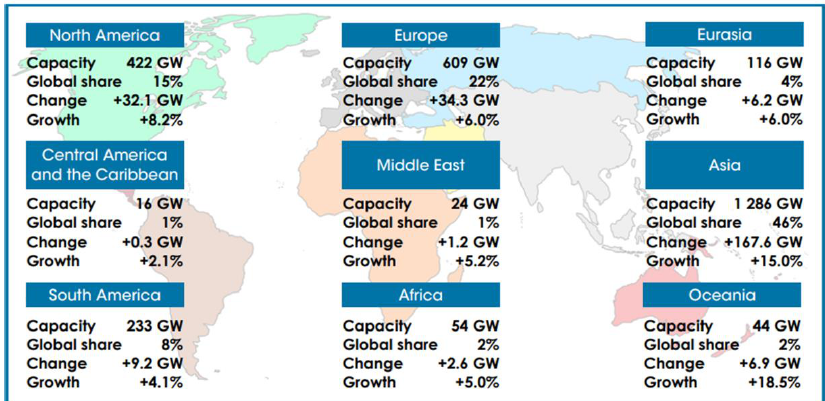
Figure 2. Renewable Energy Resources (RERs) growth capacity in gigawatt (GW) by continent